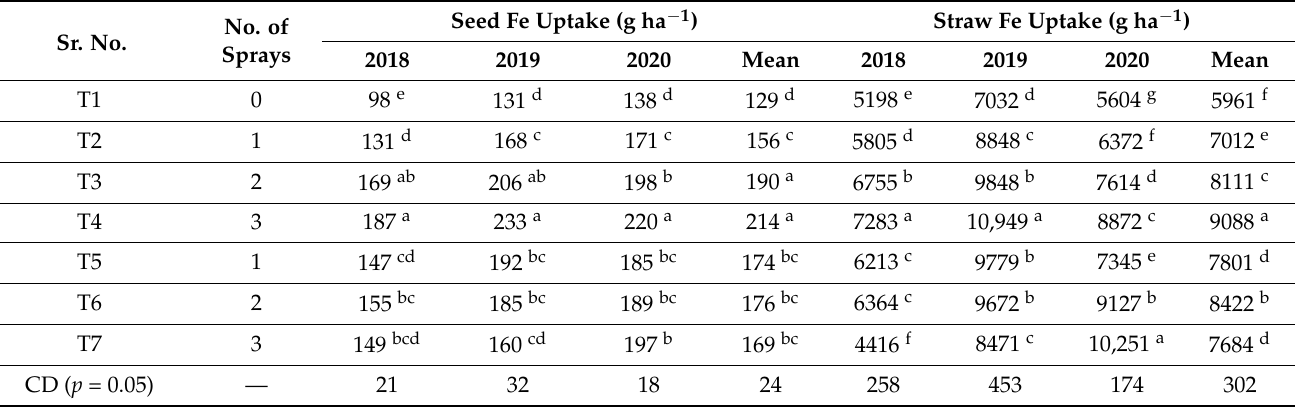
Table 4. Impact of foliar application of FeSO 4 · 7H 2 O on Fe uptake of soybean.